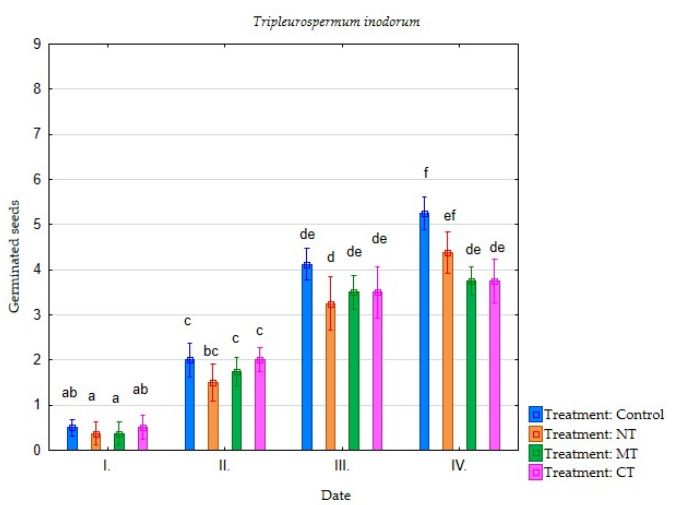
Figure 7. Development of the germination of Tripleurospermum inodorum caryopses watered with soil leachates from different soil tillage. The results represent the mean of 8 biological replicates ± SE. Identical letters express statistical non-significance between the variants, different letters express statistical significance at a significance level p = 0.05 (Fisher LSD test). The plot shows the mean, the whiskers representing the standard error, values with different letter (a, b, c, d, e, f) differ significantly. Variants of tillage technologies: CT—Conventional tillage with ploughing; MT—Minimum tillagethe; NT—Direct sowing.